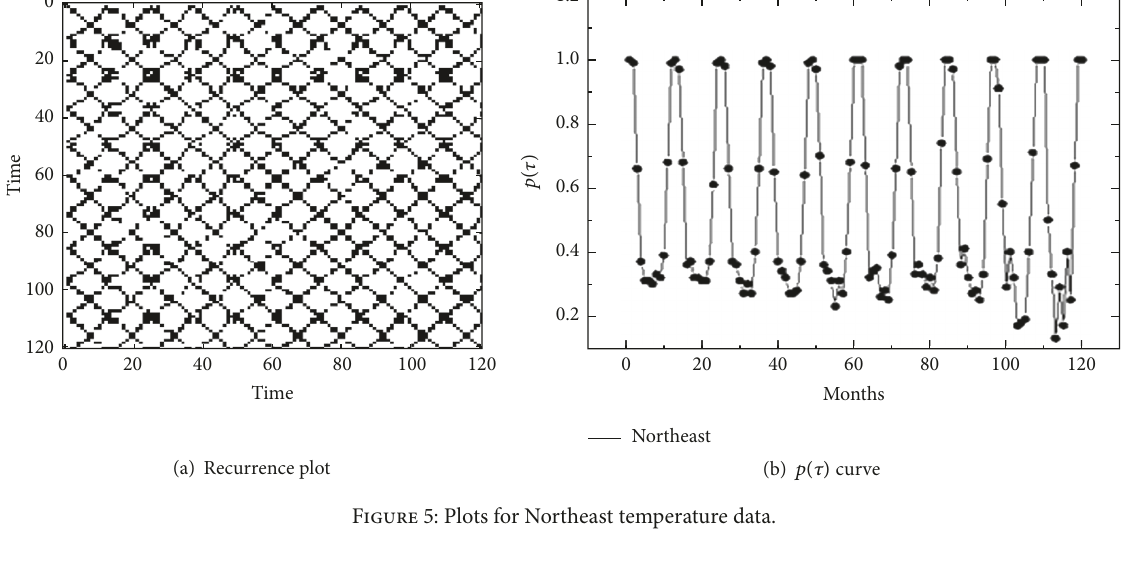
Figure 5: Plots for Northeast temperature data.